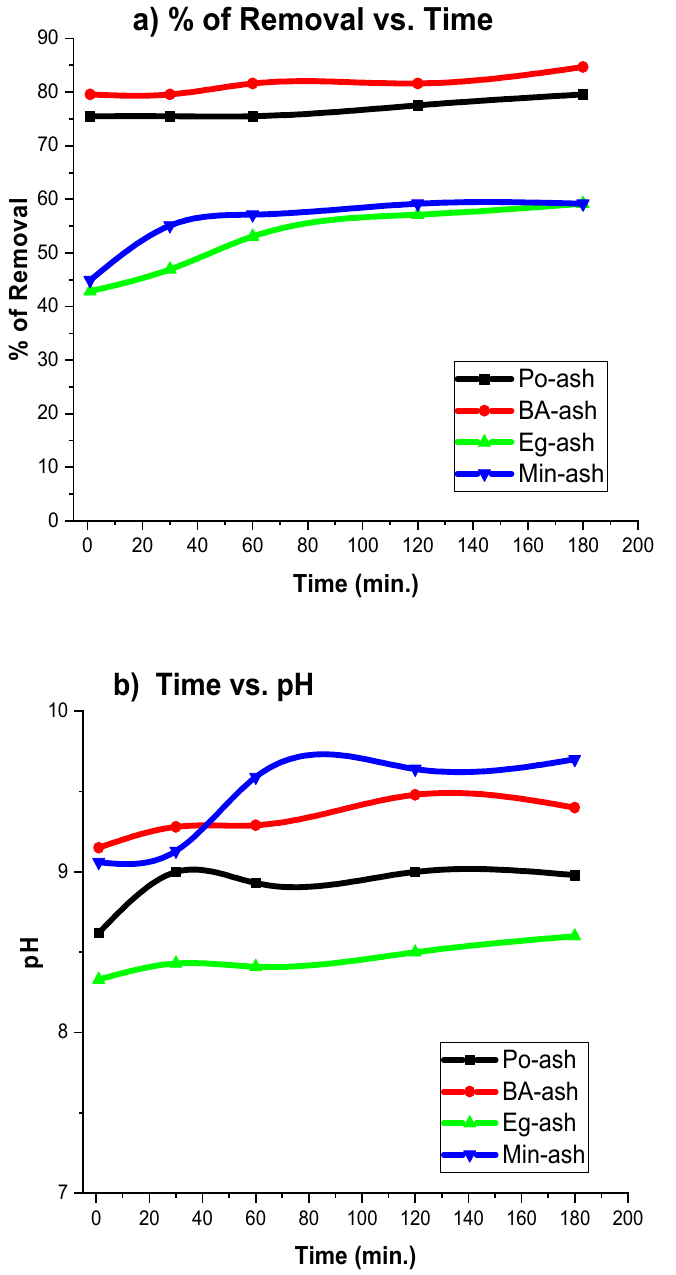
Figure 10. ( a ) Contact time versus removal of Ca ions; ( b ) contact time versus pH of the solution.